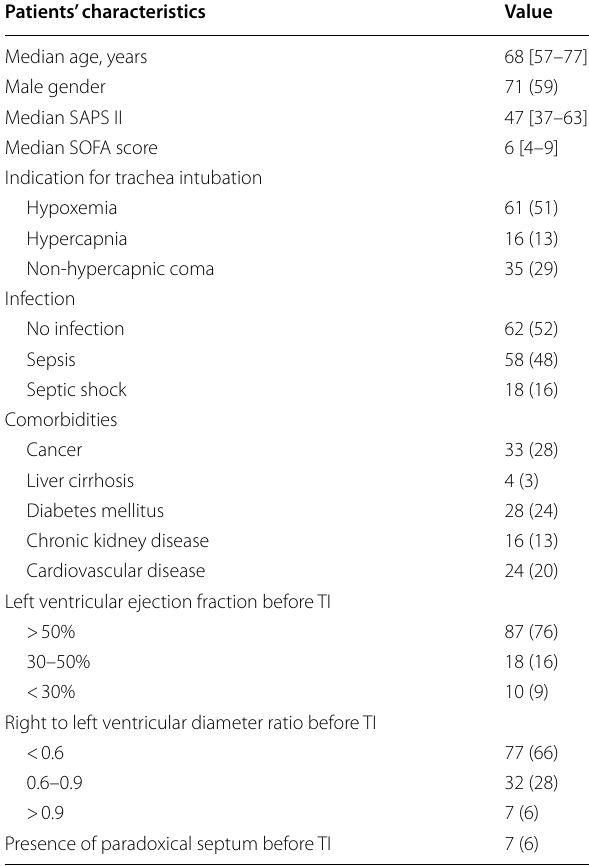
Table 1 Baseline characteristics of patients included in the